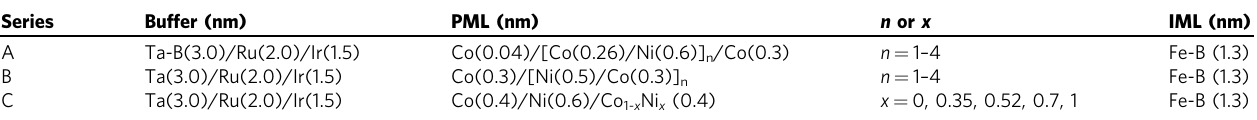
Table 1 Summary of the trilayer-based stack